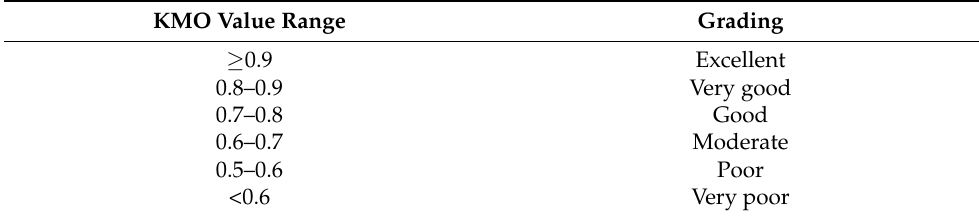
Table 7. KMO value range and significance grading scale.